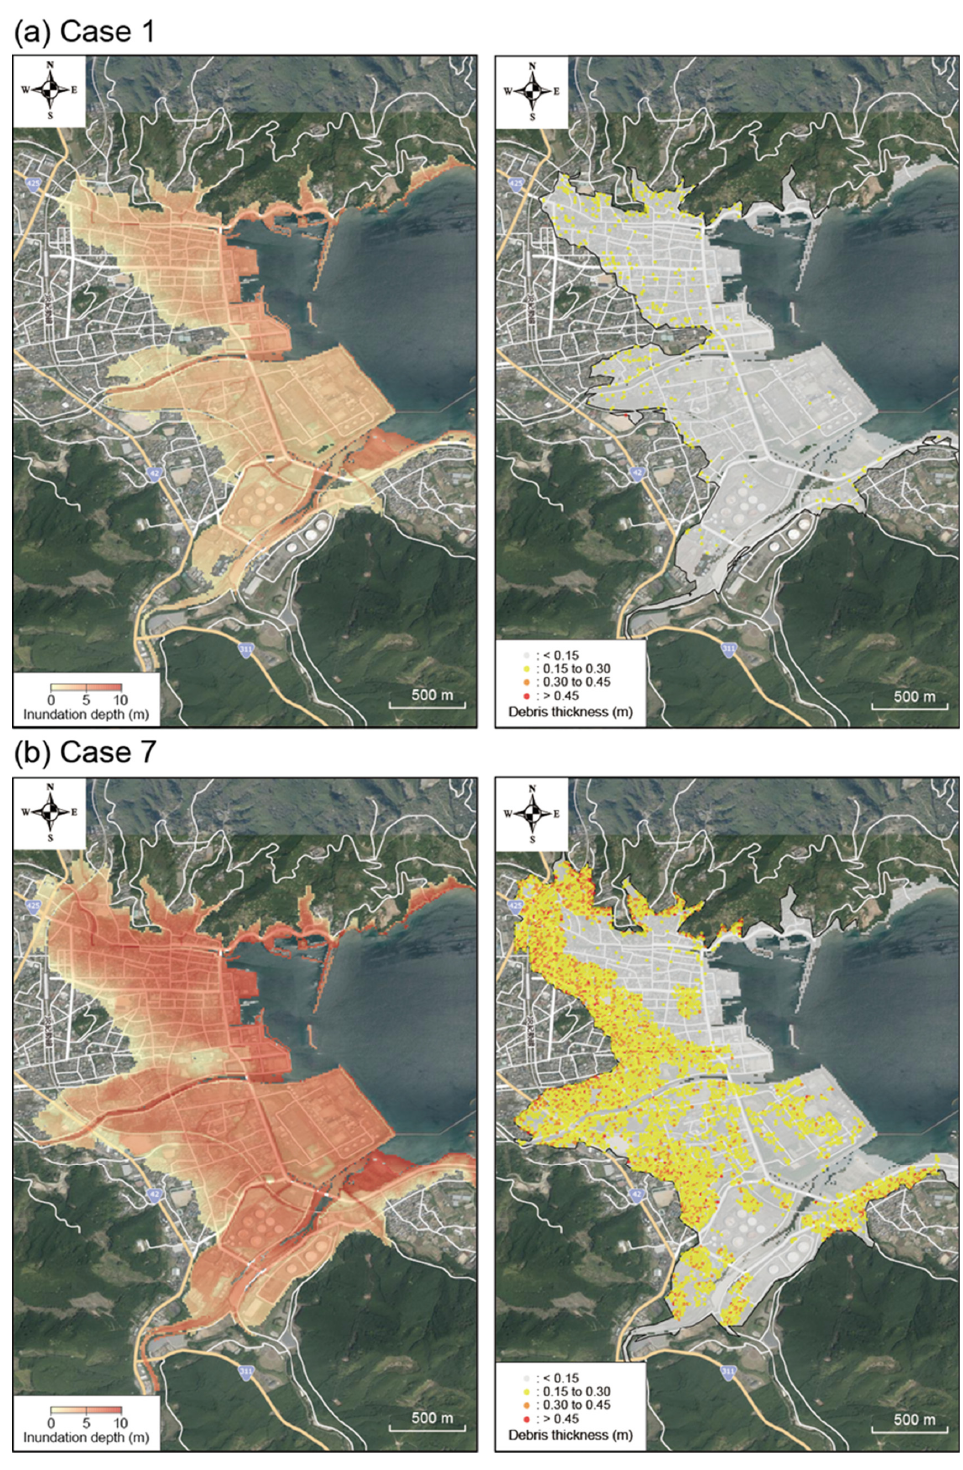
Figure 17. Tsunami inundation areas and distributions of accumulated debris thickness in Owase City according to ( a ) Case 1 and ( b ) Case 7 attribution of debris accumulation. The solid lines indicate the route network, the white lines indicate prefectural route with 2 lanes or less, and the ivory lines indicate large national route with two or more lanes.